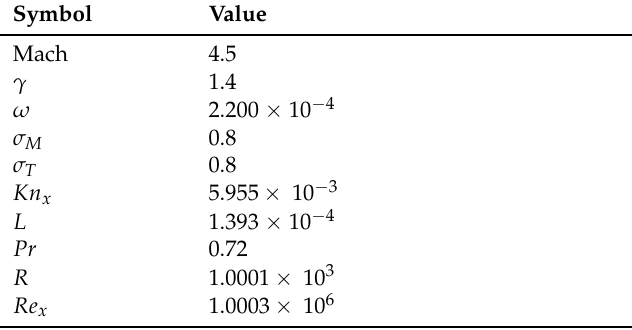
Table 1. Non-dimensional and dimensional parameters for the B.L. flow stability